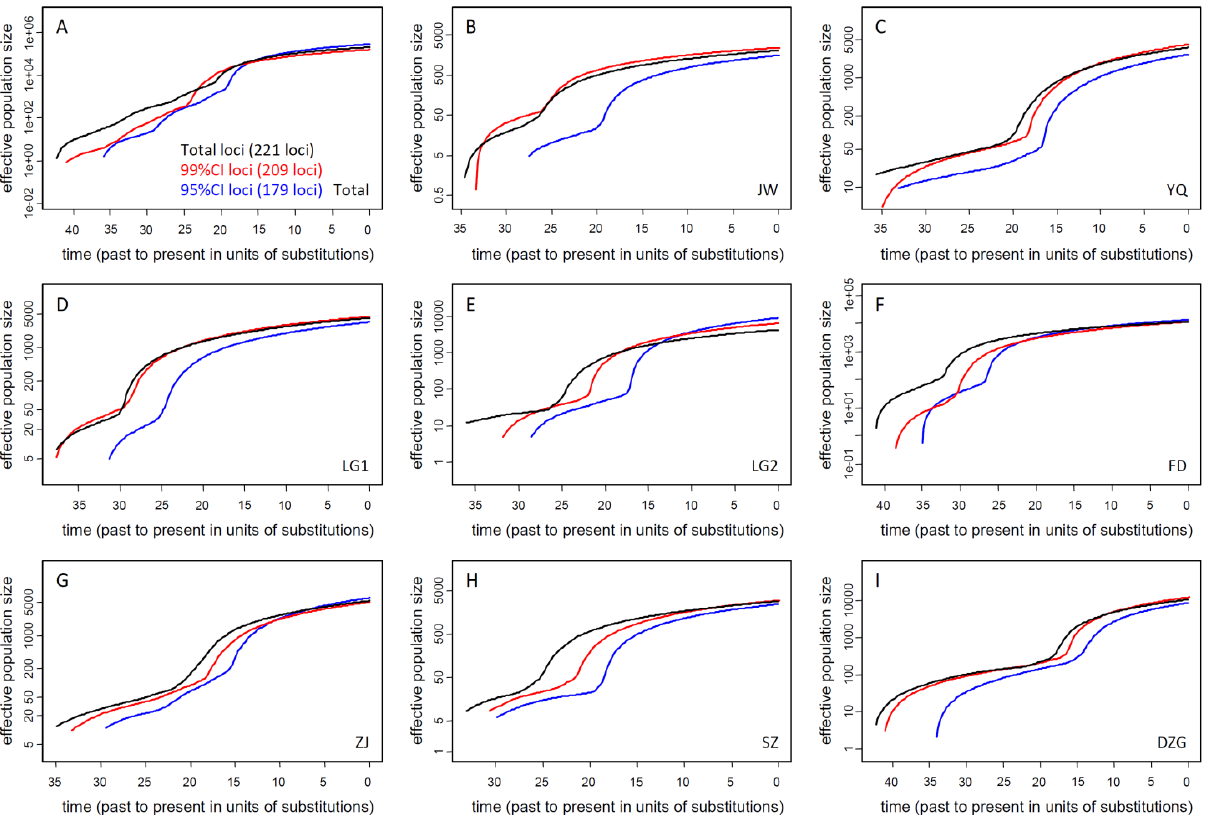
Figure 3. The rjMCMC skylines of ( A ) total populations and ( B – I ) every single population of K. obovata in Southeastern China. Black, red, and blue lines are the estimated median values of total loci, 99% CI loci, and 95% CI loci,